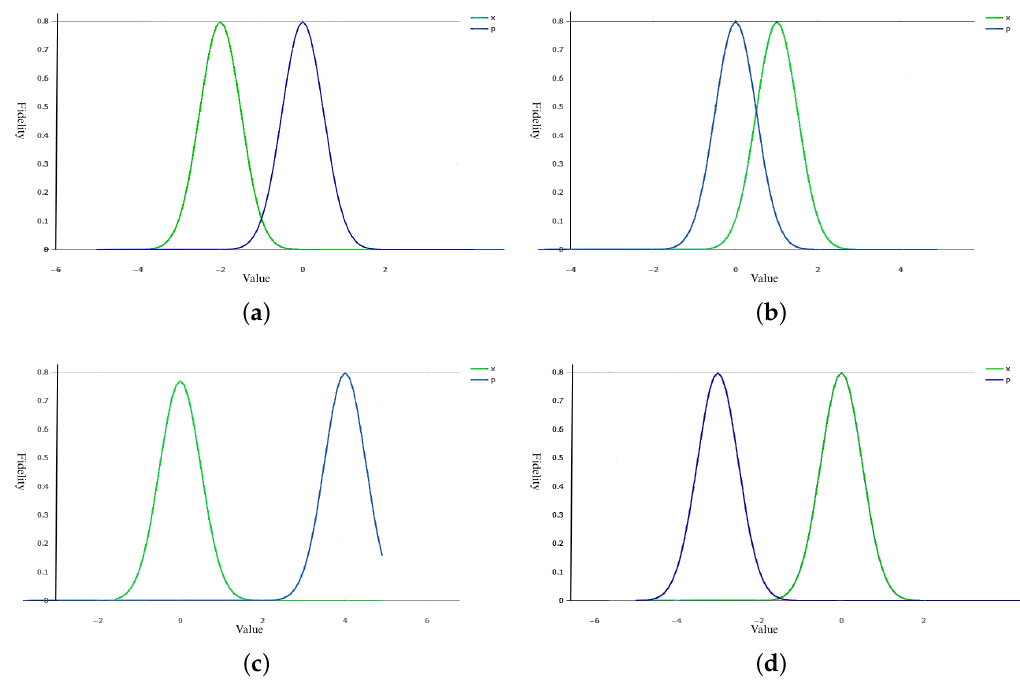
Figure 5. Experimental results. The subfigures ( a – d ) represent the output of the first mode, the second mode, the third mode and the forth mode, respectively. The vertical axis indicates the probability that x or p takes a value on the horizontal axis. Besides, x and p can take the corresponding value under the maximum probability to form a coherent state